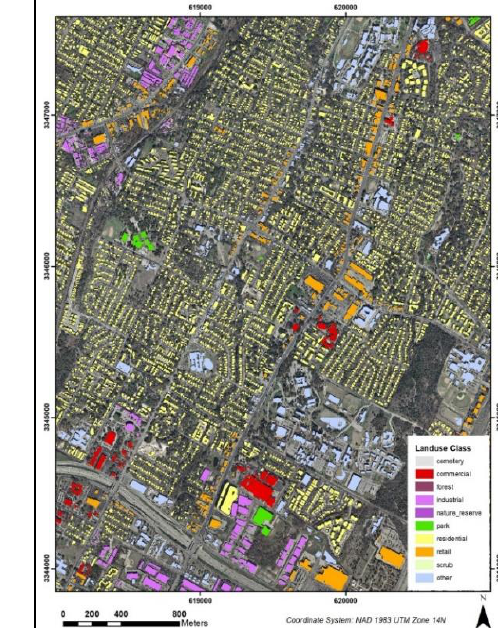
Figure 14. Map showing the calculated population count of each building in Vienna. Figure 15 shows an evaluation of the results of the attribute extraction process. Here, we compared the same part of Vienna with land use data and population data. Buildings belonging to different land use categories and buildings showing a higher population count were selected, and the selected buildings were identified in Google Street View. The selected land use categories belong to commercial, industrial, residential, retail, and oth- ers. When these buildings were identified, it was proved that these land use classes were